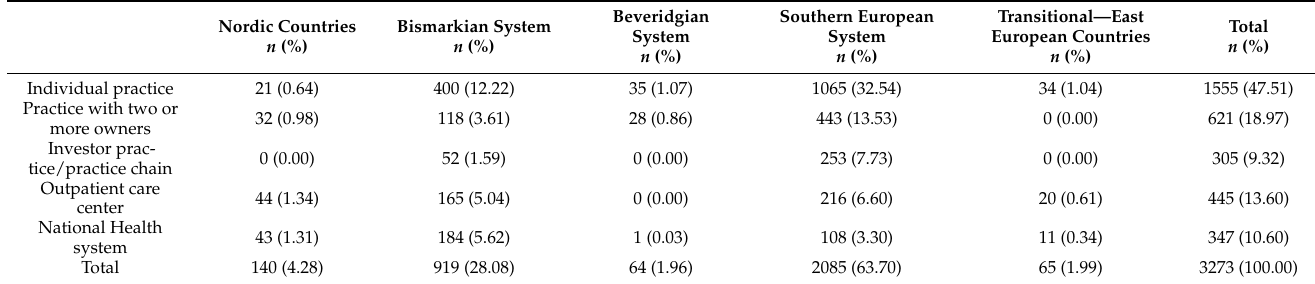
Table 4. Type of institution where a new dentist would like to